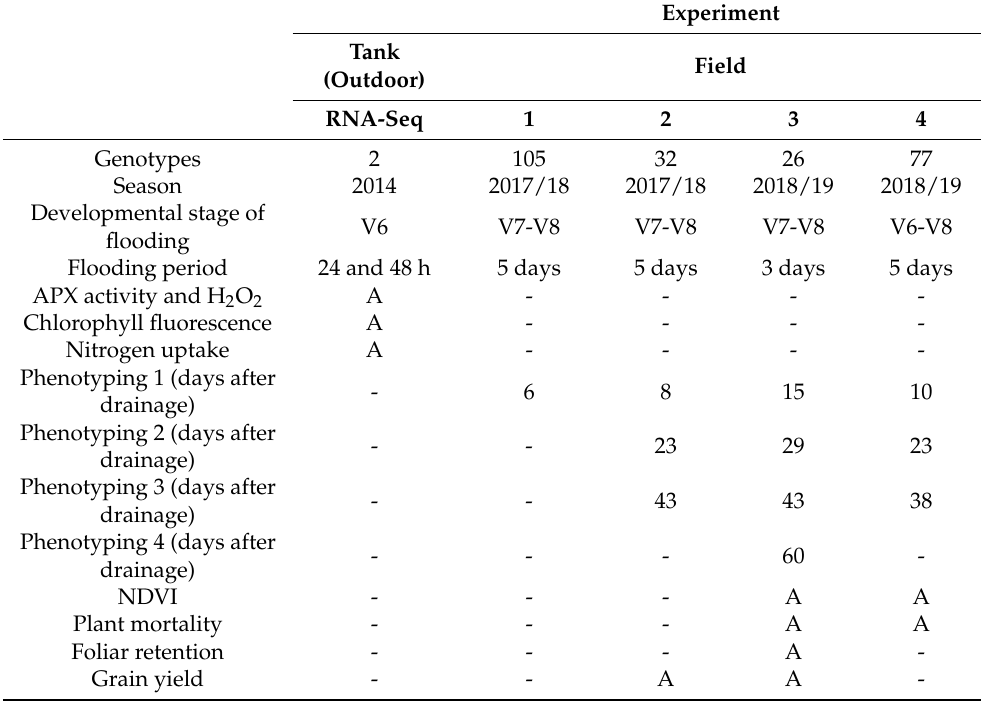
Table 11. Phenotyping and physiological analyses